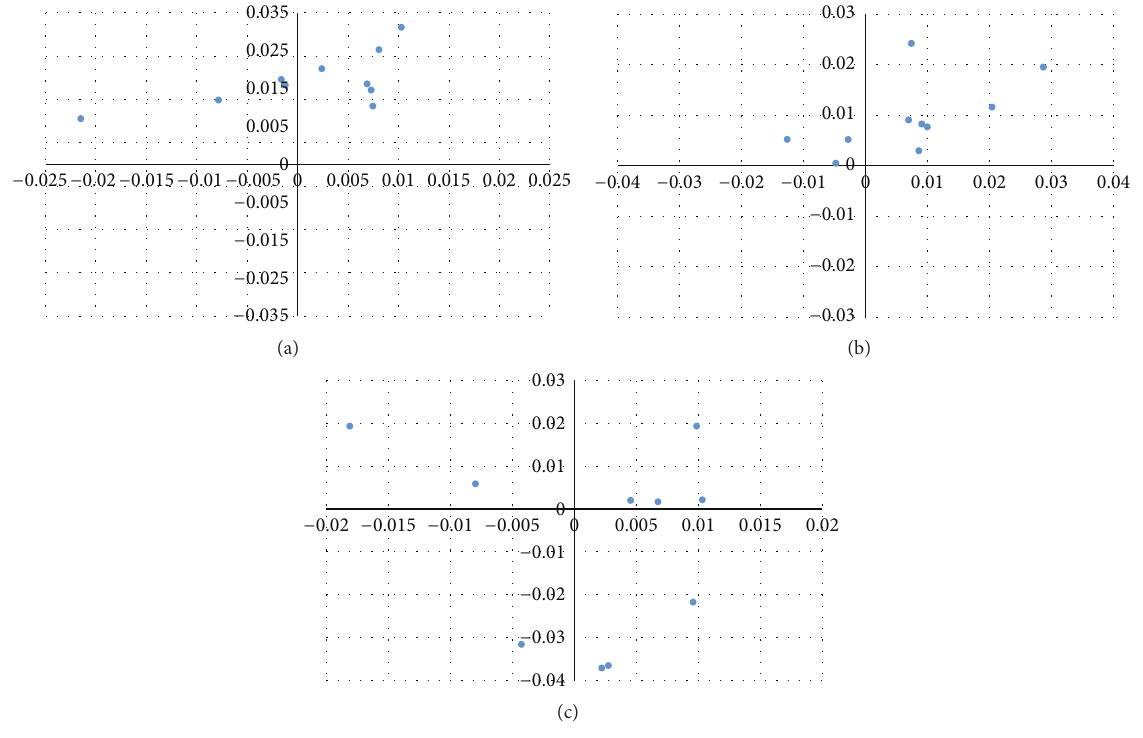
Figure 17: Robot movement position error. (a) Grasping position error. (b) Placing position error. (c) Charge station position error.